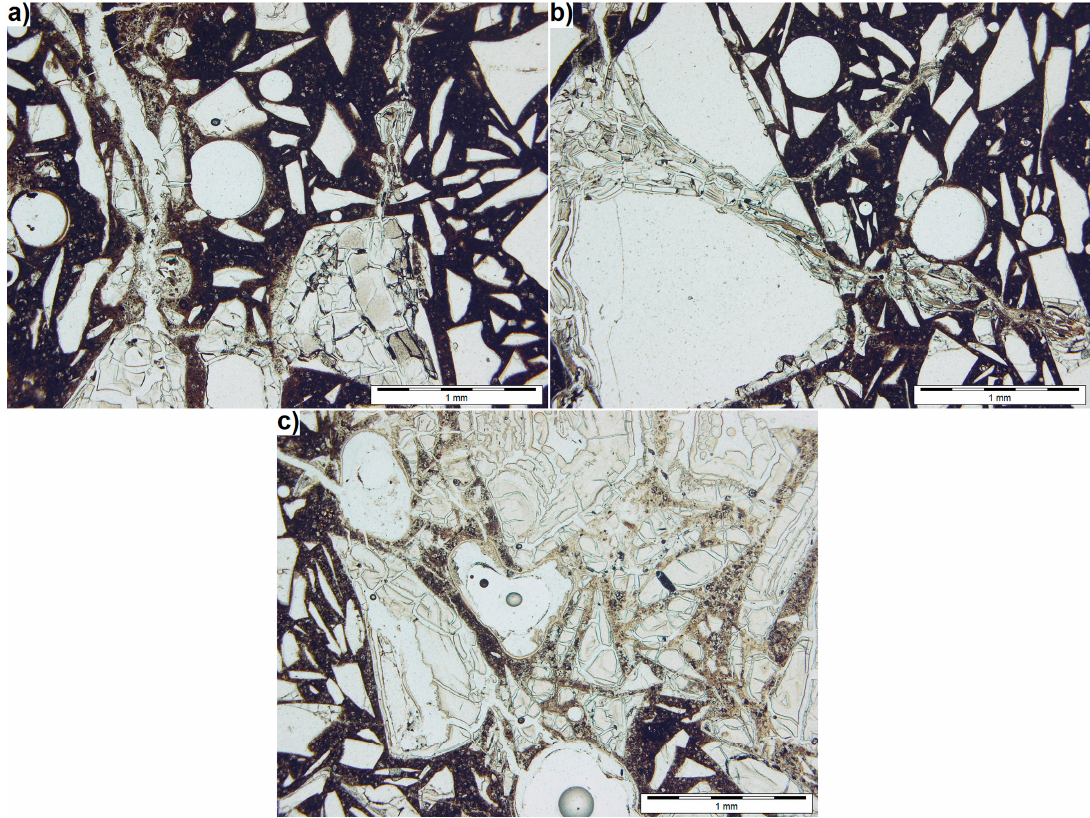
Figure 5. Thin section observed in transmitted light using a single polarizer. ( a ) typical area of cracked mortar with waste glass, ( b ) large waste glass grain having a single fracture, ( c ) strongly degraded mortar area.